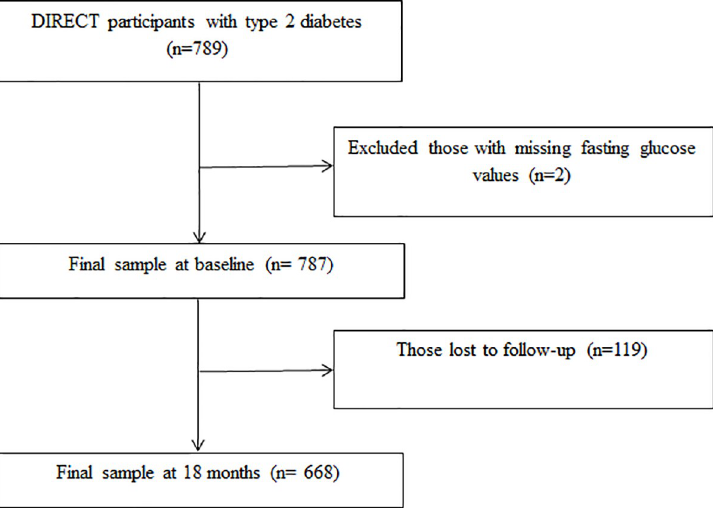
Fig 1. Flow chart of inclusion (n = 668) and exclusion (n = 221) of participants in the DIRECT study.